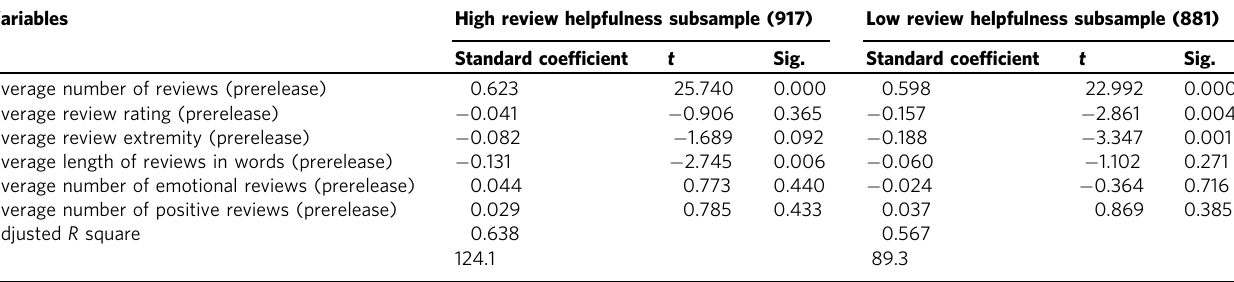
Table 3 Regression analysis for box of fi ce revenue for the fi rst week after release using review helpfulness subsample.